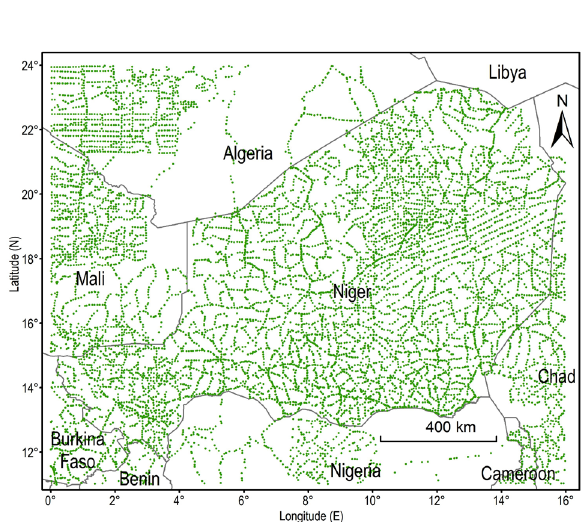
Figure 2. Spatial distribution of terrestrial gravity data